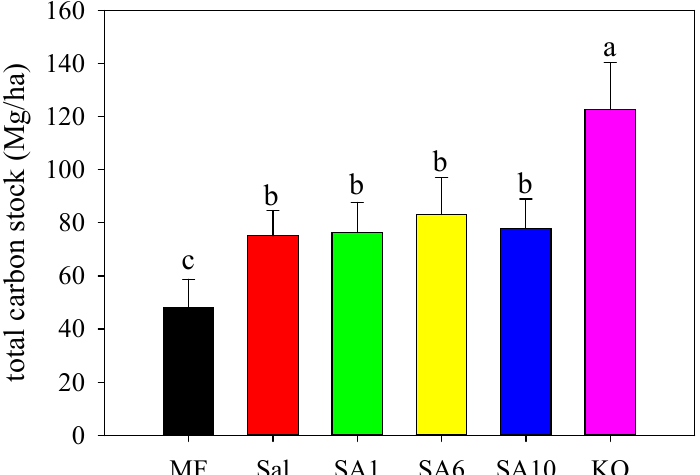
Figure 3. Total soil organic carbon stock down to 50 cm at different sites (error bar represents standard deviation of total carbon stock, letters indicate significant differences at p <